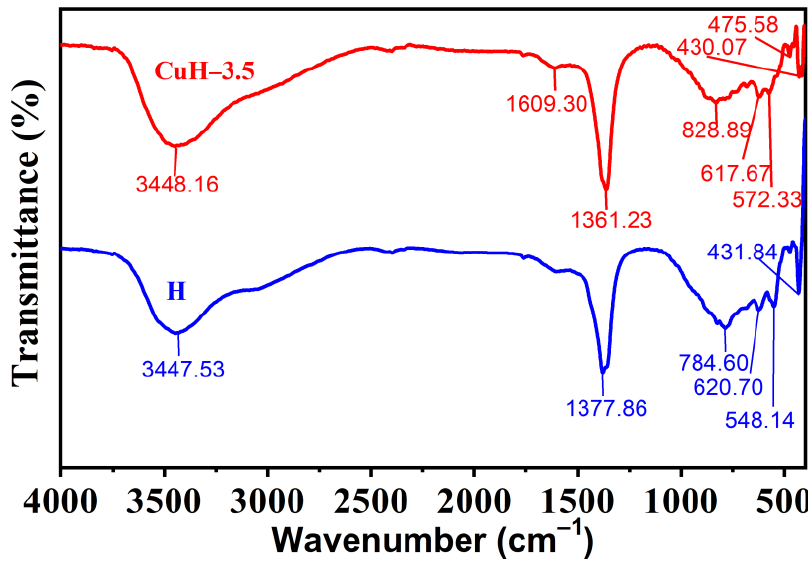
Figure 4. FT–IR spectra of the H and CuH–3.5.